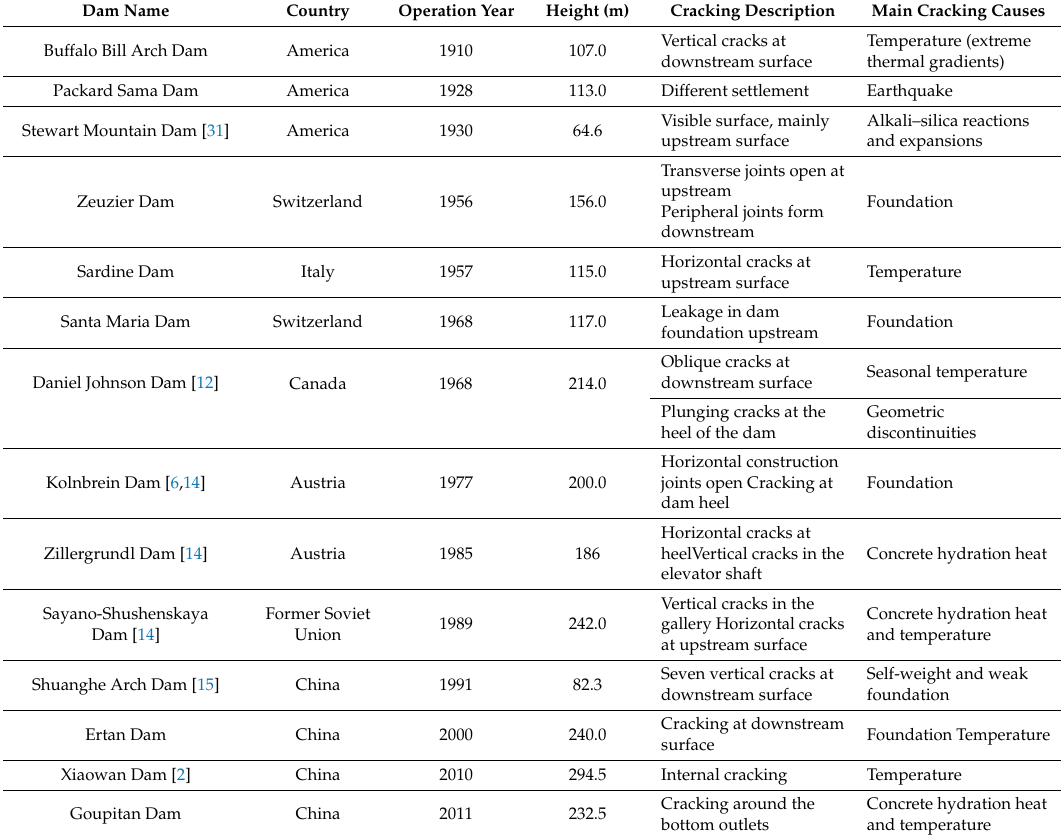
Table 1. Summary of cracking types in high arch